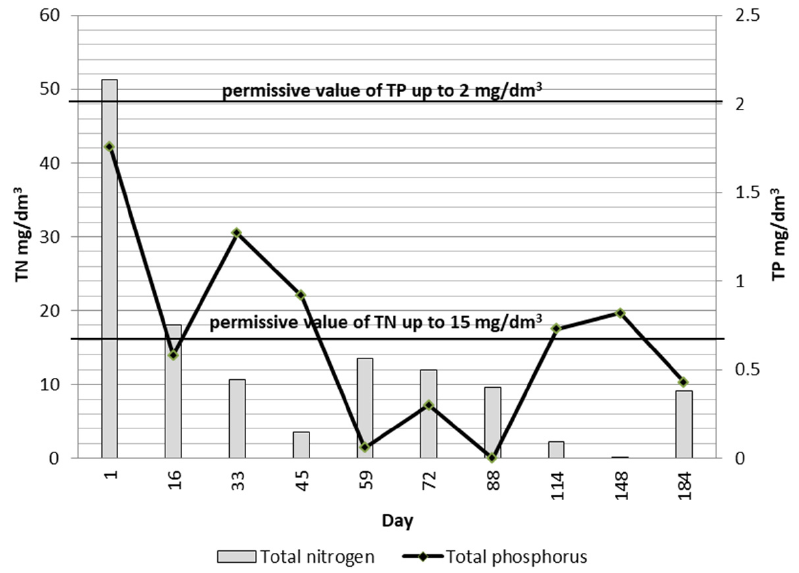
Figure 12. Changes in N and P concentrations in treated wastewater from the 1st to the 184th day of operation (April–October 2021).